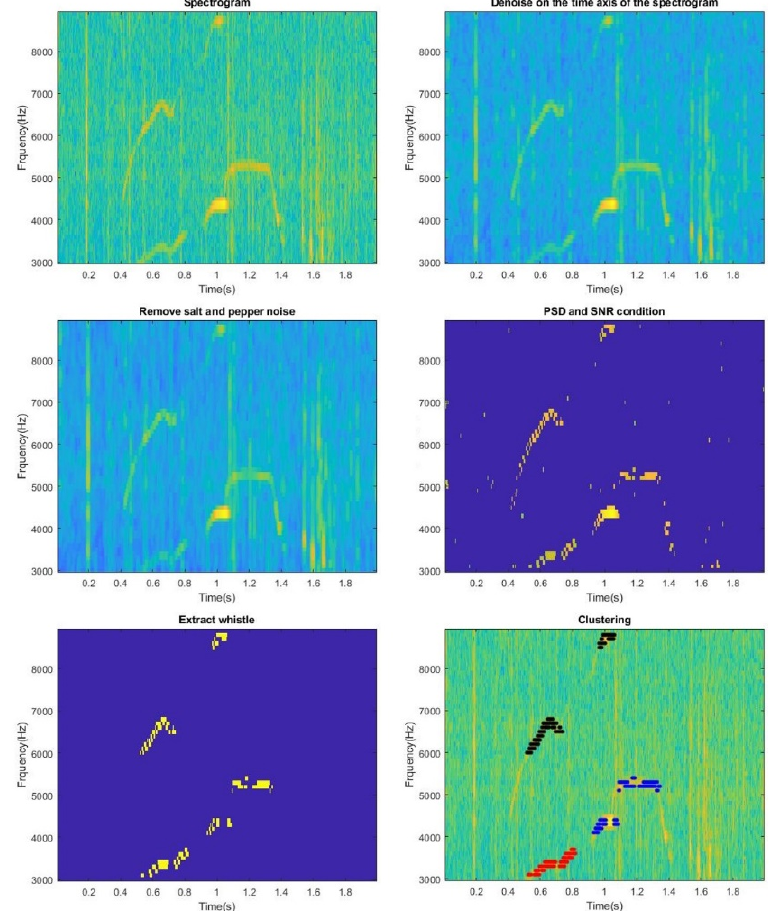
Figure 2. Each step of the results.